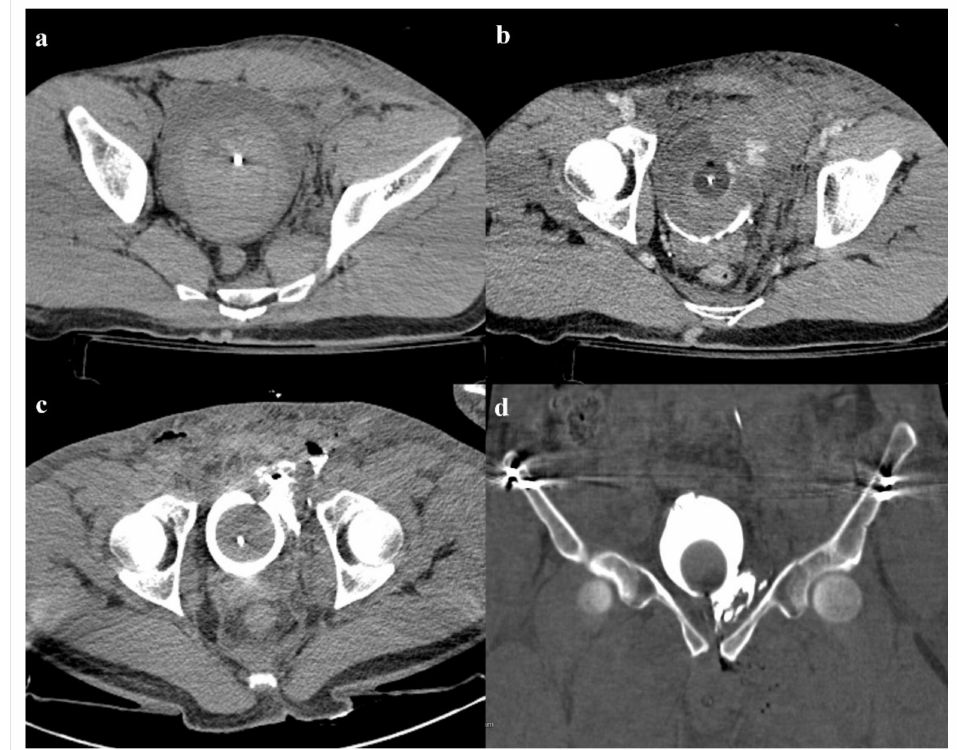
Figure 12. Patient of the Figure 5, with an anterior–posterior compression fracture. There is a large hematoma inside the bladder ( a ); contrast medium administration reveals active bleeding in the venous phase of the examination, on the left wall of the bladder ( b ). Axial and coronal CT cystography images show a leak of contrast medium in the perivesical space, suggestive of extraperitoneal bladder rupture ( c , d ).